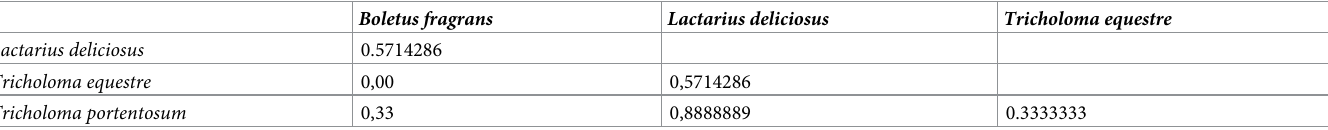
Table 4. Similarity matrix calculated using the Bryan-Curtis index of dissimilarity between the different fungal species according to the ability of establishing ecto- mycorrhizae with the different tested Cistaceae